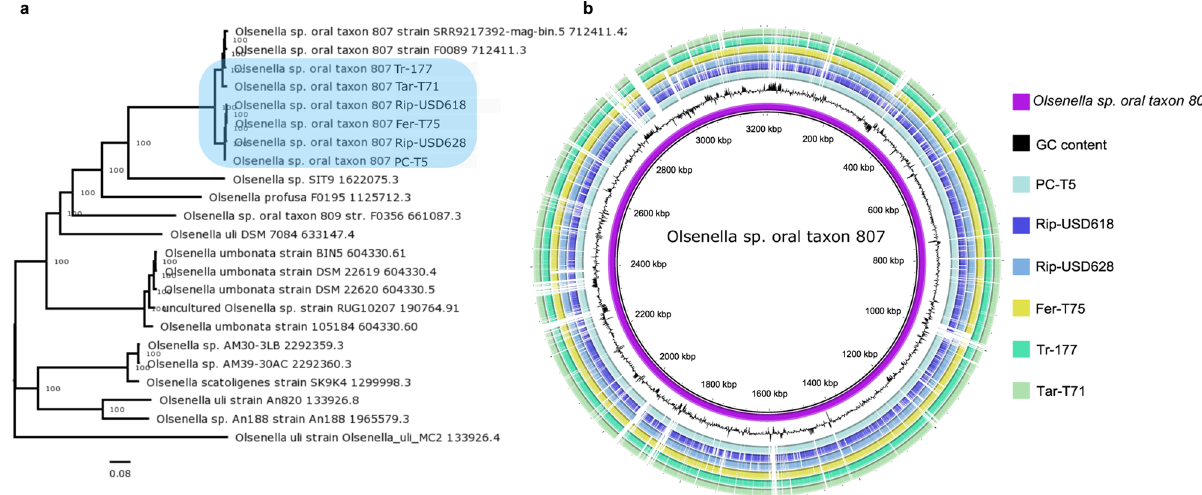
Fig. 5 | Ancient Olsenella sp. oral taxon 807 reconstruction. Panel a reports the phylogenetic analysis of the six reconstructed ancient genomes (light-blue box), together with 17 modern Olsenella sp. references, as performed by PATRIC 100 . In Panel b , it is possible to observe the alignment analysis conducted with BRIG 99